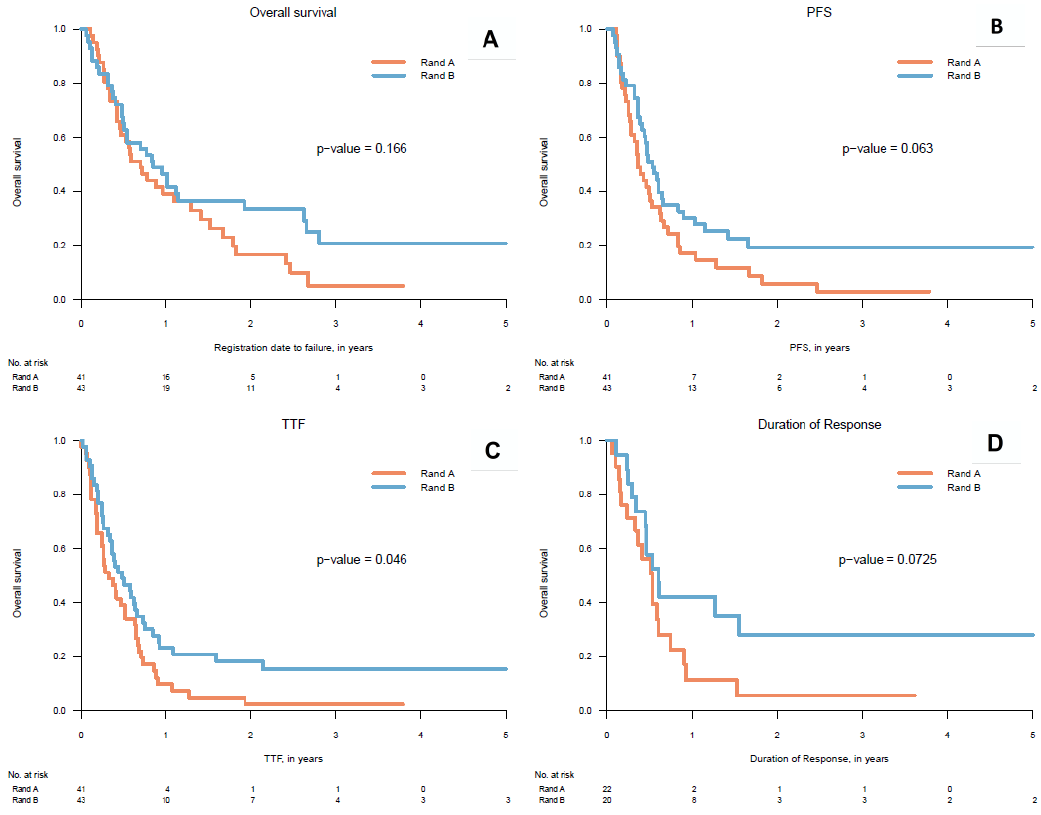
Figure 2. Kaplan Meier curves, rand A: Randomization Arm A, rand B: Randomization Arm B, ( A ) OS: Overall Survival, ( B ) PFS: Progression-Free Survival, ( C ) TTF: Time to Treatment Failure, ( D ) Duration Of Response. Table 2. Multivariate analysis (only corrected for gender).